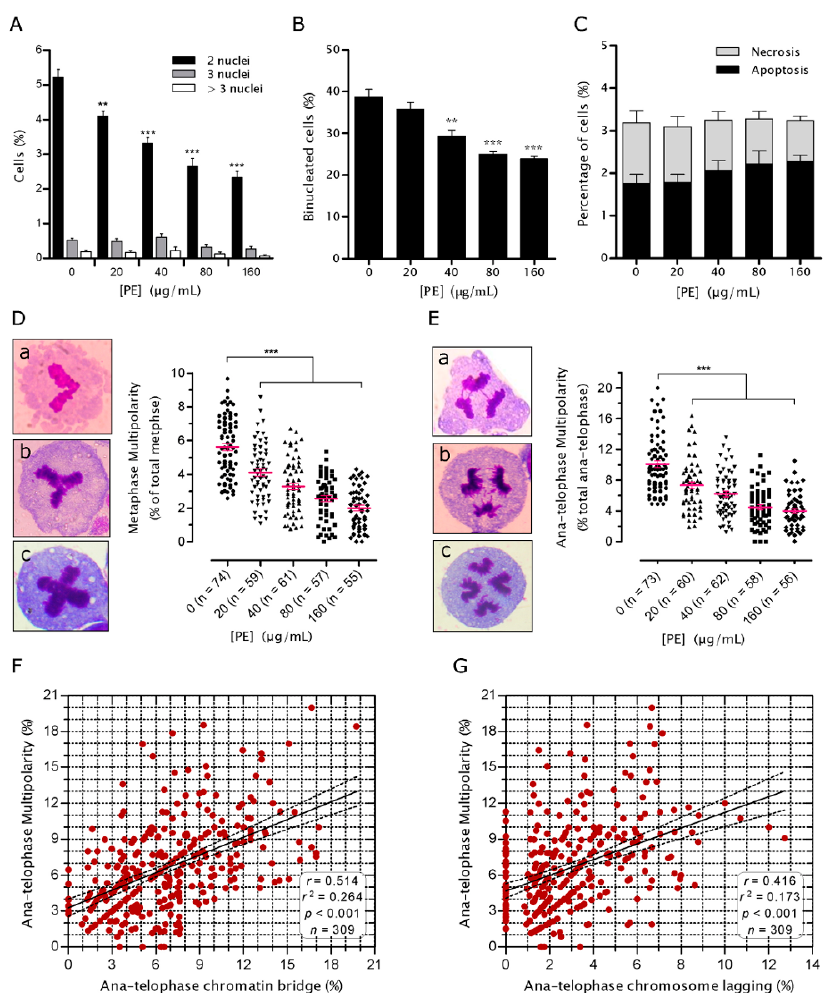
Figure 4. P. emblica (PE) treatment prevented NCM460 cells from multinucleation and multipolar mitosis. ( A ) Quantification of the multinucleation ( ≥ 2 nuclei) indices of in NCM460 cells from indicated PE doses. NCM460 cells were treated without or with PE (20–160 µg/mL) for 72 h, then cells were immediately fixed and stained for quantitative analysis of multinucleation and multipolarity; ( B , C ) Effects of PE on the frequency of binucleated cells ( B ) and cell death ( C ) in the presence of cytochalasin B. NCM460 cells were incubated for 24 h with the indicated doses of PE in combination with cytochalasin B (1.5 µg/mL). A minimum of 500 cells per PE dose from each of at least three independent experiments was analyzed; ( D ) Representative examples in left panel show the L-shaped ( a ), Y-shaped ( b ) and cross-shaped ( c ) arrangement of spindle poles (100× oil objective, Giemsa staining). Quantification of the percentage of multipolar metaphases from indicated PE doses is shown in right panel. Each mark depicts the quantification of one case from >200 metaphases; ( E ) Representative images in left panel show the tri-polar ( a , b ) and tetra-polar ( c ) anaphases (100× oil objective, Giemsa staining). The right panel shows the quantification of ana-telophase multipolarity from indicated PE doses. Each mark depicts the quantification of one case from >50 ana-telophases. In ( D , E ), Giemsa-stained DNA is in red, and the cytoplasm is in blue; n indicates the total cases quantified per PE dose; horizontal lines indicate the mean values and error bars depict the SEM ( F , G ). Linear regression plot showing the correlations between chromatin bridge (CB; F ), chromosome lagging (CL; G ) and ana-telophase multipolarity. Each red spot is representative of one pair of multipolarity and CB or CL from an individual case. The solid line is the weighted regression and the dotted lines are 95% confidence bands. r , Pearson’s correlation; n , the total quantified pairs. Data are expressed as mean values ± SEM. ** p < 0.01; *** p < 0.001 vs. untreated control.